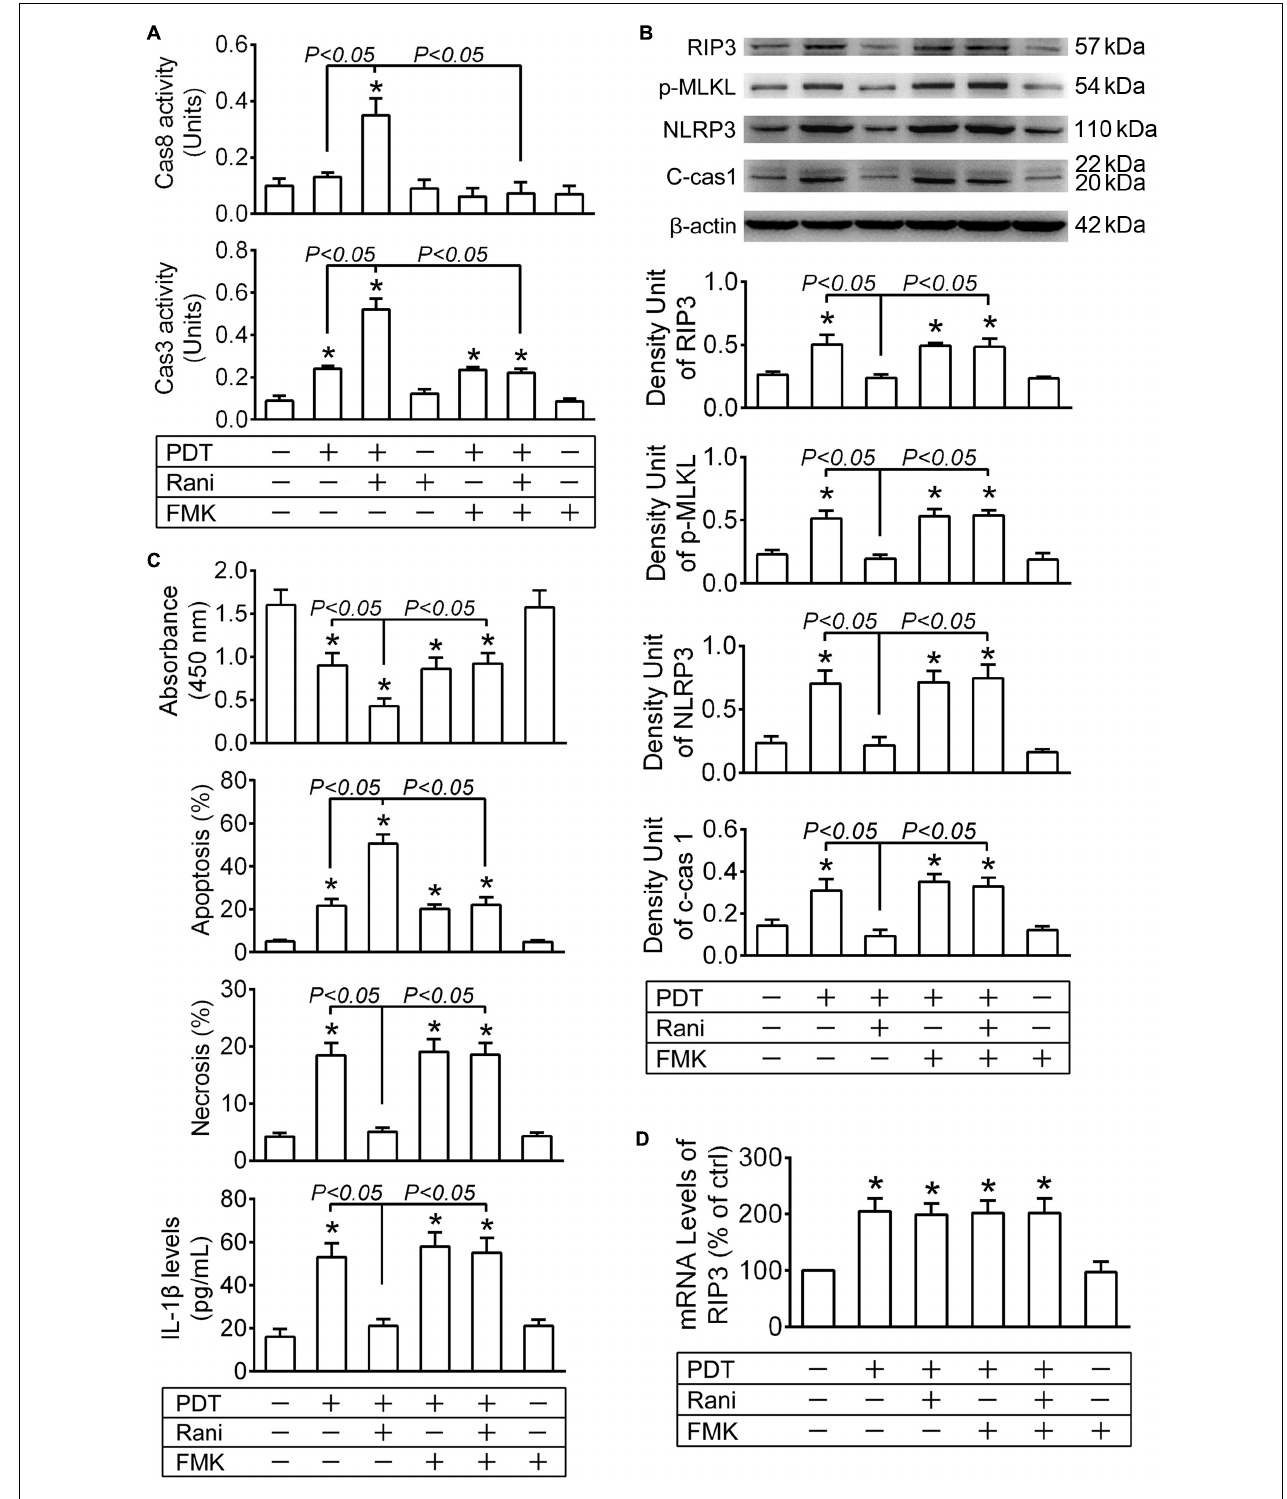
FIGURE 3 | Cas8 inhibition reverses rani’s effects of preventing PDT-induced RIP3 upregulation and its downstream events. RF/6A cells were exposed to PDT, rani was applied to the cells at 6 h before PDT, and Z-IETD-FMK (FMK, a selective cas8 inhibitor) were administrated right after PDT. Various detections were performed at 12 h after PDT. (A) Cas3 and cas8 activitiy in RF/6A cells was measured using cas3 and cas8 colorimetric activity assay kits. (B) The protein levels of RIP3, p-MLKL, NLRP3 and c-cas1 in RF/6A cells were detected by immnoblotting. (C) Cell viability was tesed with CCK-8, cell apoptosis and necrosis were determined by flow cytometry, and IL-1 β protein levels in cell culture medium were assayed using a monkey IL-1 β ELISA kit. (D) The mRNA levels of RIP3 were measured by real-time PCR analysis. n = 4; * P < 0.05, compared with the control.